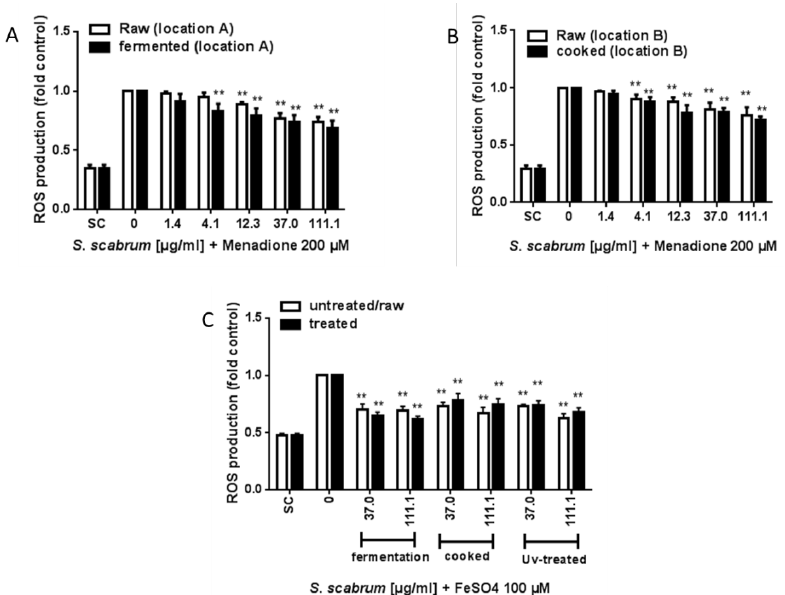
Figure 4. Anti-oxidant activity of raw, processed and UV-C treated ethanolic S. scabrum extracts. Inhibition of ROS production was determined by the EPR method in response to 200 µM menadione ( A , B ) or 100 µM FeSO 4 ( C ) in HepG2 cells. Data are means ± SEM of three independent experiments expressed as fold control (SC: solvent control, 0.1% DMSO + 0.7% ethanol ( A , B ) or supplemented DMEM medium ( C )) + 0.7% ethanol). Asterisks indicate statistically significant differences between the respective treatment and the positive control (without S. scabrum leaf extract) p ≤ 0.01 (**).